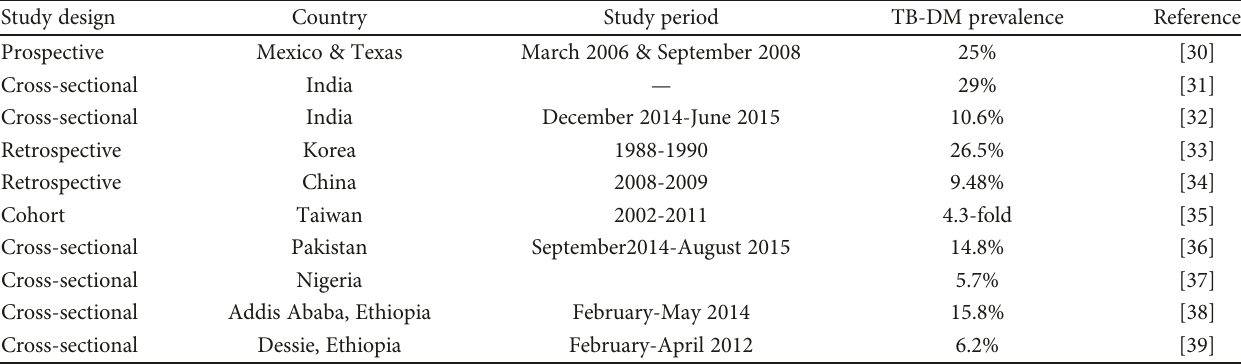
Table 1: Summary of 10 studies of the association between diabetes and tuberculosis, at the University of Gondar, Ethiopia, 2018. Study